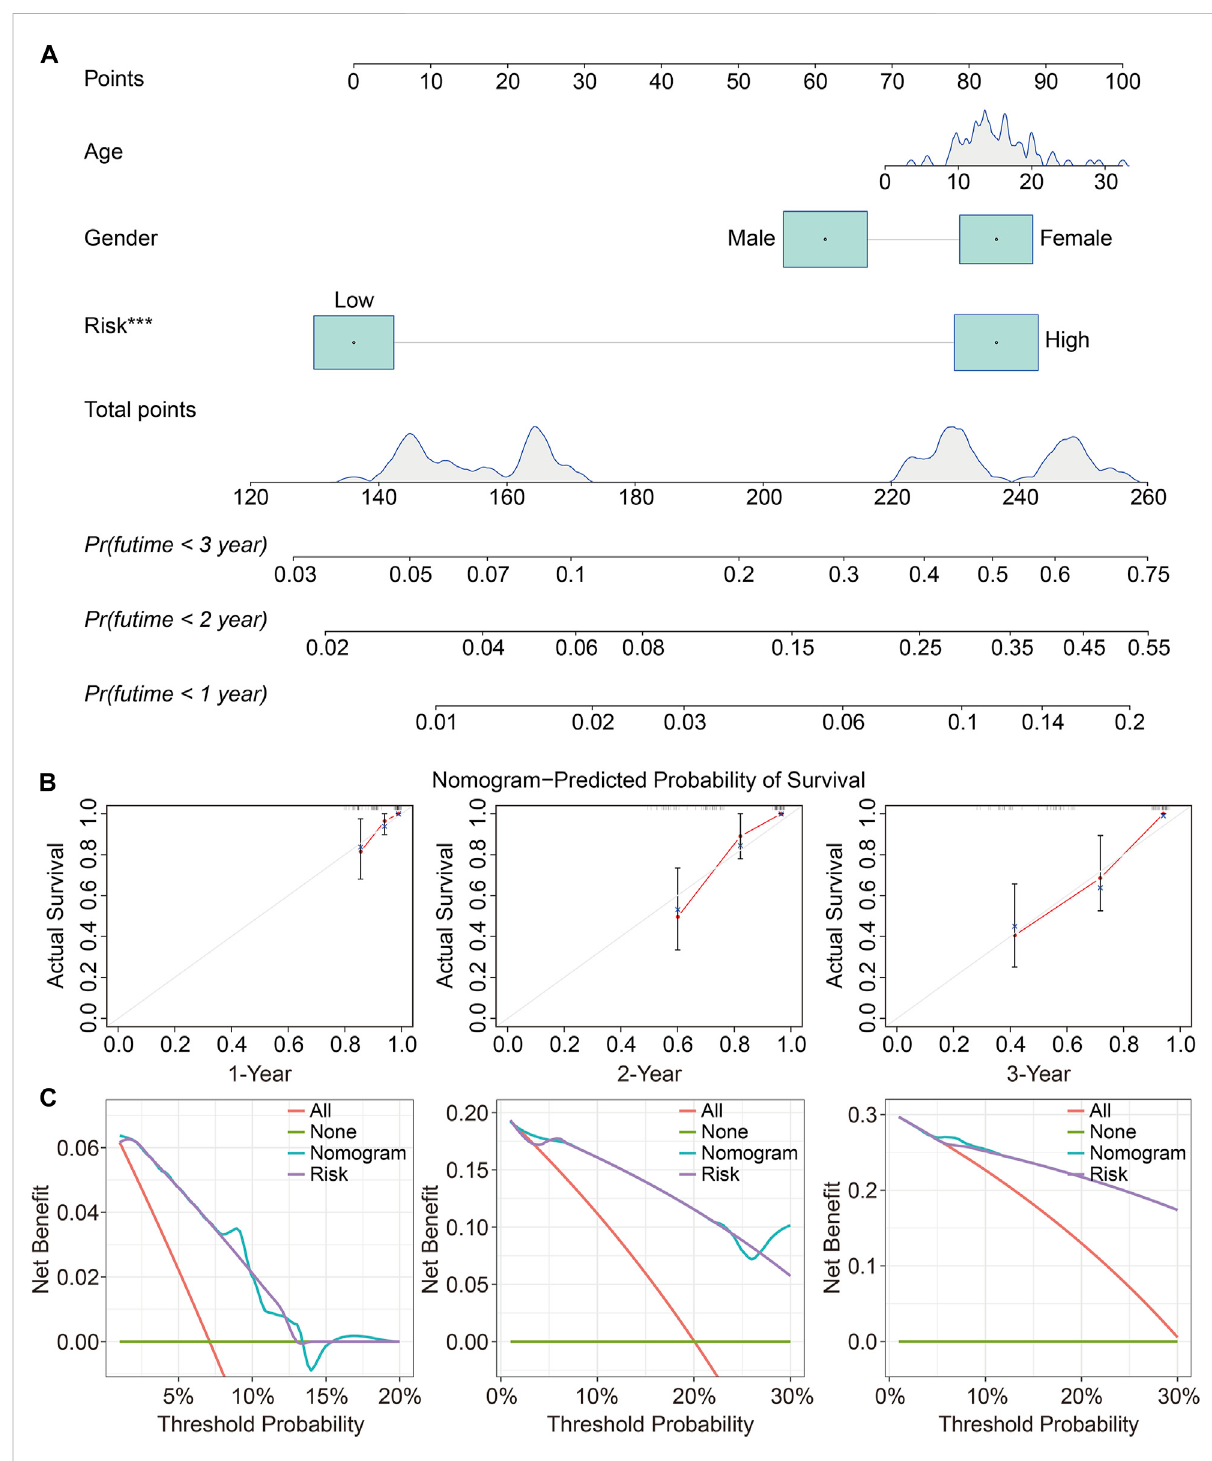
FIGURE 6 Construction and validation of a prognostic nomogram in osteosarcoma. (A) A nomogram was developed by integrating age, gender, and relative risk score. (B) Calibration curves exhibit the prediction performance of the nomogram in the TCGA cohort. (C) Decision curves for 1, 2, and 3